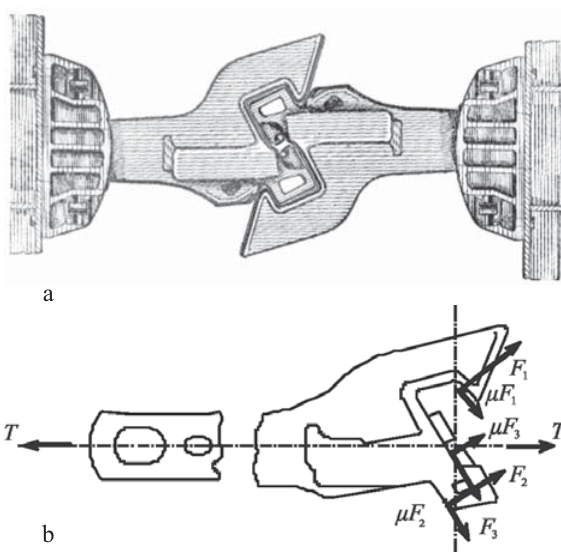
Fig. 1. Th e automatic coupler in railway carriages in operation (a); the distribution of forces acting on the body of the automatic coupler in railway carriages